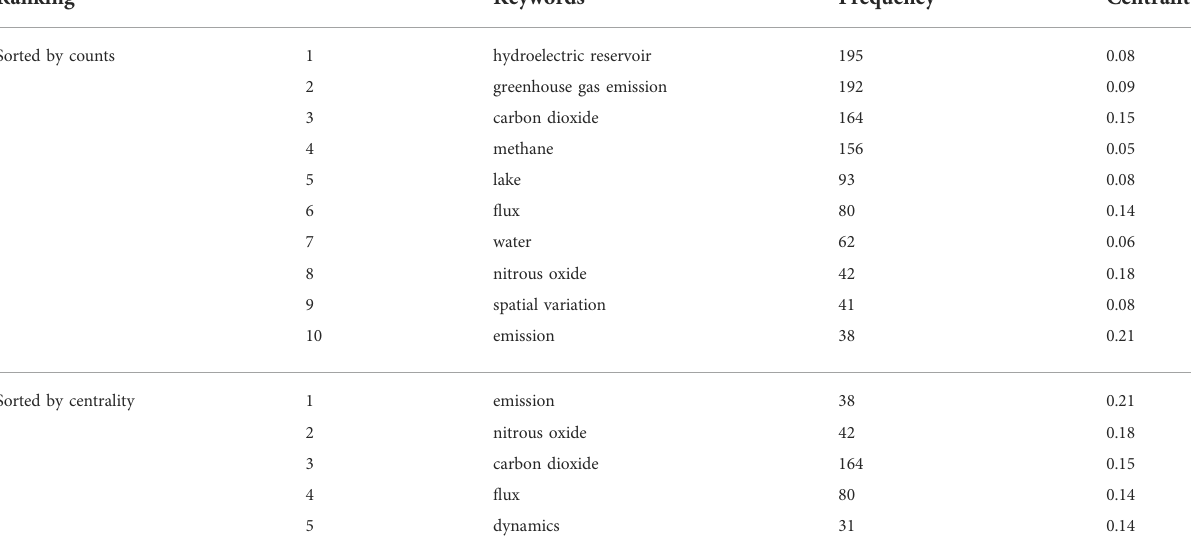
TABLE 8 Keywords with a high frequency and centrality in GHG-HR research fi eld. Ranking Keywords Frequency